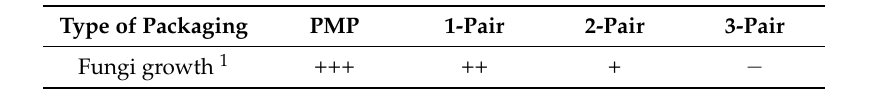
Figure 7. Photograph of stretched and rolled PMP with three-pair SiO x /SiC x H y stack.